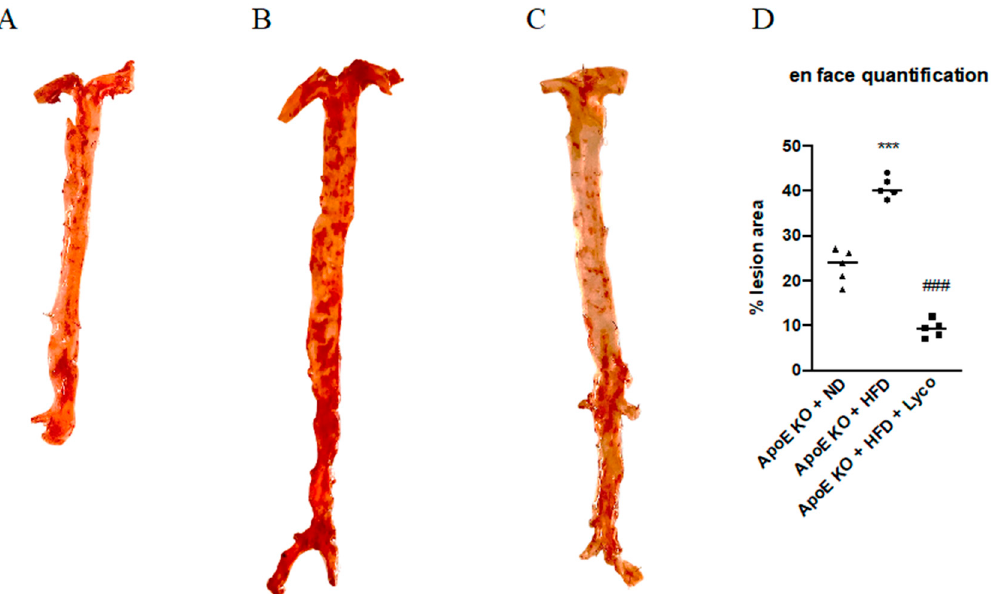
Figure 2. Effects of Lycopene on percentage of lesion surface area in aortas samples stained with oil-red-o from ApoE KO + ND ( A ), ApoE KO + HFD ( B ), and ApoE KO + HFD + Lyco ( C ) groups. The graph in ( D ) shows the quantification of the percentage of atherosclerotic plaque surface area. Values were obtained from 5 animals per group and are expressed as the means ± SD. *** p < 0.0001 vs. ApoE KO + ND; ### p < 0.0001 vs. ApoE KO + HFD.